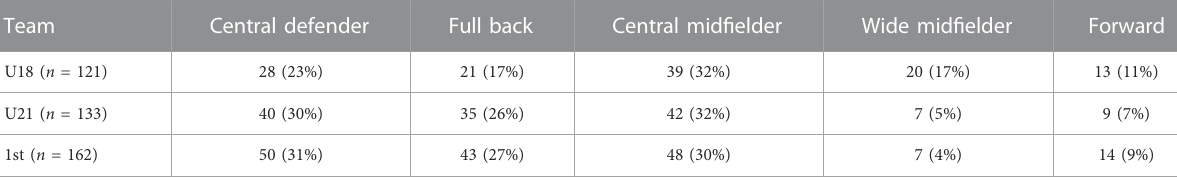
TABLE 5 Number of individual match observations per team and position. Data presented as n (%).